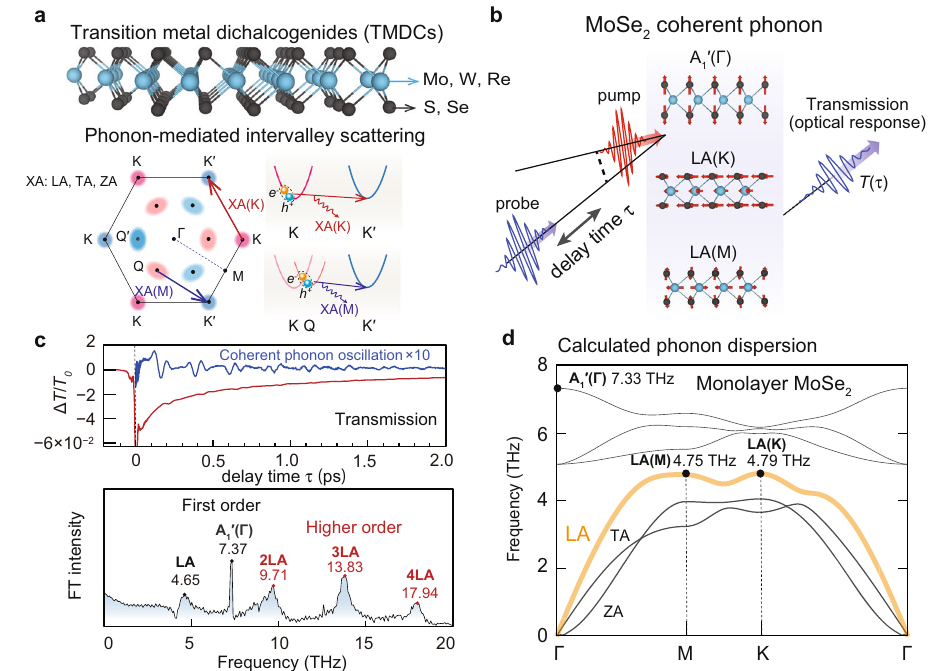
Fig. 1 | Schematic illustration of phonon-mediated intervalley scattering pro- cessesandexperimentalultrafastpump-probedetectionofmonolayerMoSe 2 . a The atomic structure of transition metal dichalcogenides (TMDCs) and valley scattering processes mediated by XA(K) and XA(M) phonons (XA:LA, TA, and ZA). b Schematic illustration of the pump-probe detection of the ultrafast optical response of monolayer MoSe 2 modulated by coherent phonon generation. c The